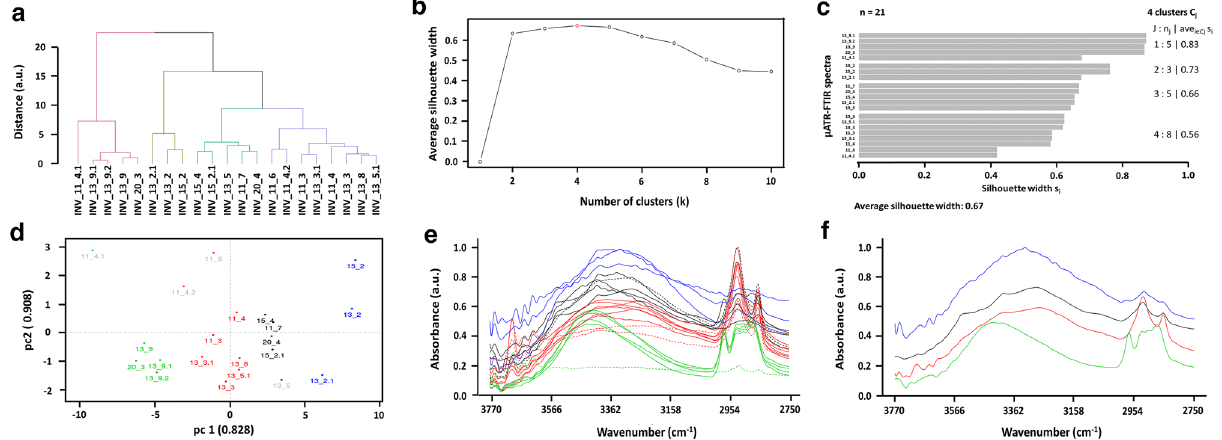
Figure 3. Statistical analysis performed on µATR-FTIR spectra for the 3770–2750 cm −1 interval. The hierarchical relationship between the spectra is represented by the dendrogram depicted in ( a ), while ( b , c ) show the estimation of the number of clusters using the average silhouette width and the obtained silhouette of clusters, respectively. PCA results, µATR-FTIR spectra, and the most representative (i.e., deepest) curve for each identified cluster (highlighted with different colours) are illustrated in ( d – f ). For clarity, the most external spectra of the clusters are underlined in ( d ) with the grey